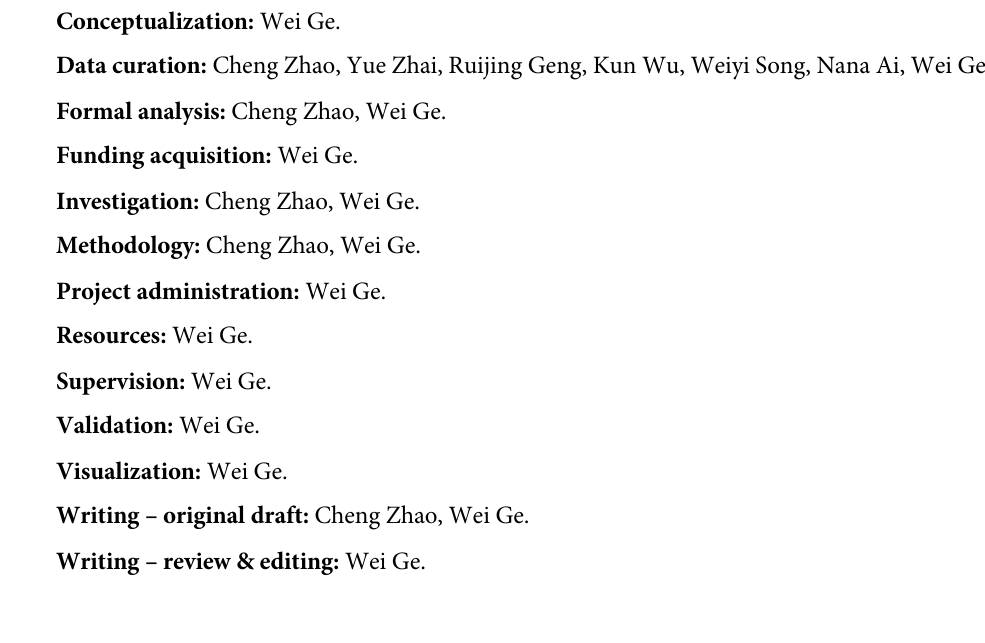
(C) Activin β B mutant males ( inhbb-/- ) at 180 dpf. (D) Quantification of spermatozoa-filled luminal spaces in the testis at 120 and 240 dpf for activin β A mutant males and 180 dpf for β B mutant males (n = 4). S3 Fig. Expression of gonadotropins ( fshb and lhb ) in the pituitary of activin β mutants. (A) Expression of fshb and lhb in the pituitary of female β A mutants at 120, 180 and 240 dpf (n = 3). The double mutant ( inhbaa-/-;inhbab-/- ) was not included for 180 and 240 dpf due to high mortality. Different letters in each dataset indicate statistical significance (p < 0.05). (B) Expression of fshb and lhb in the pituitary of male and female β A ( inhbb ) mutant at 180 dpf. S4 Fig. Expression of selected gonadal genes and members of the activin-inhibin-follistatin system in the ovary and testis of activin β A and β B mutants. (A) Gene expression in the ovary of activin β A ( inhbaa , inhbab ) mutants at 90 dpf (n = 4–5). (B) Gene expression in the testis of the β A mutants at 90 dpf (n = 5). (C) Gene expression in the ovary of β B mutant ( inhbb ) at 180 dpf (n = 4). (D) Gene expression in the testis of the β B mutant at 180 dpf (n = 4). The expression levels are normalized to ef1a and presented as the fold change com- pared with the control fish. The asterisks indicate statistical significance ( � p < 0.05, �� p < 0.01 and ��� p < 0.001). S1 Table. Primer used for CRISPR, HRMA and